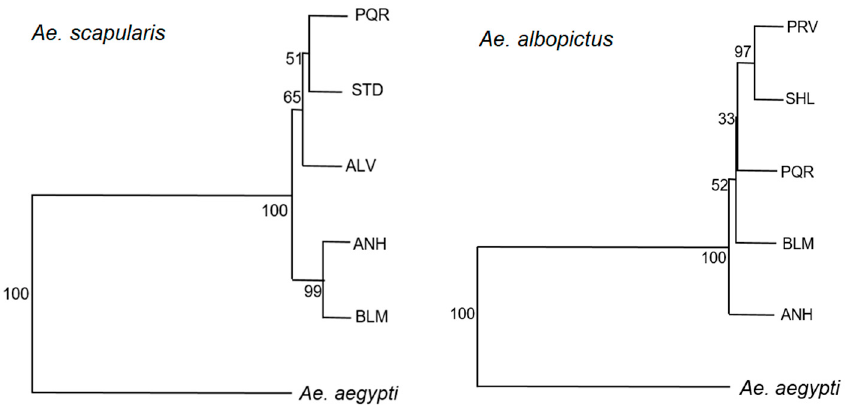
Figure 4. Neighbor-Joining tree based on Mahalanobis distances for Ae. scapularis and Ae. albopictus Figure4. Neighbor-JoiningtreebasedonMahalanobisdistancesfor Ae. scapularis and Ae. albopictus populations. populations.